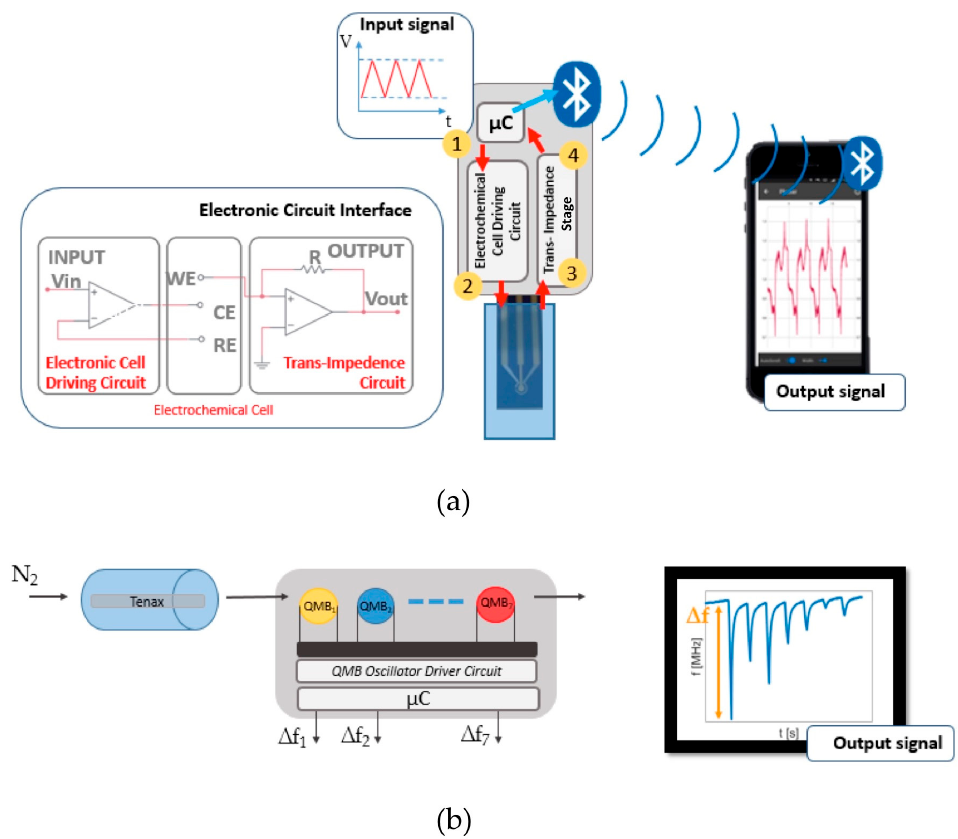
Figure 1. Device used in the experimental set-up: ( a ) BIONOTE-L ( b ) BIONOTE-V.